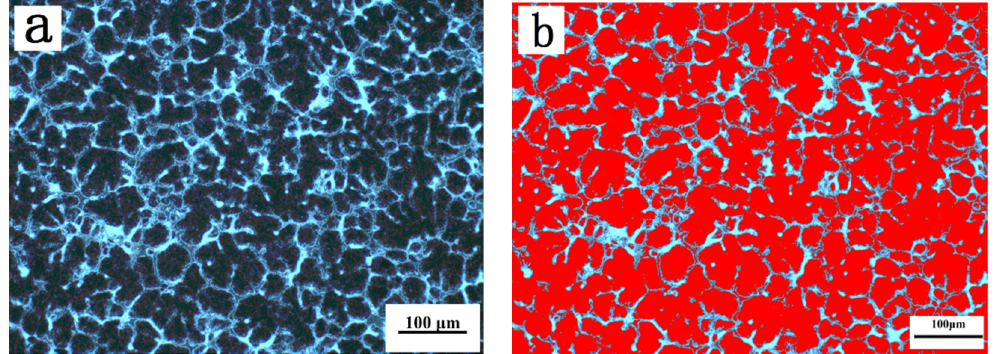
Figure 10. Area fraction of carbide in the different samples of the M2 steel billets.